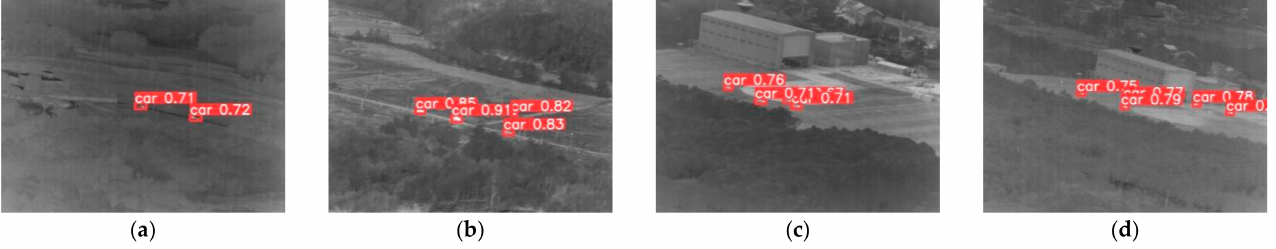
Figure 22. Dense + Ghost detection diagram. ( a ) Scene 1. ( b ) Scene 2. ( c ) Scene 3. ( d ) Scene 4.